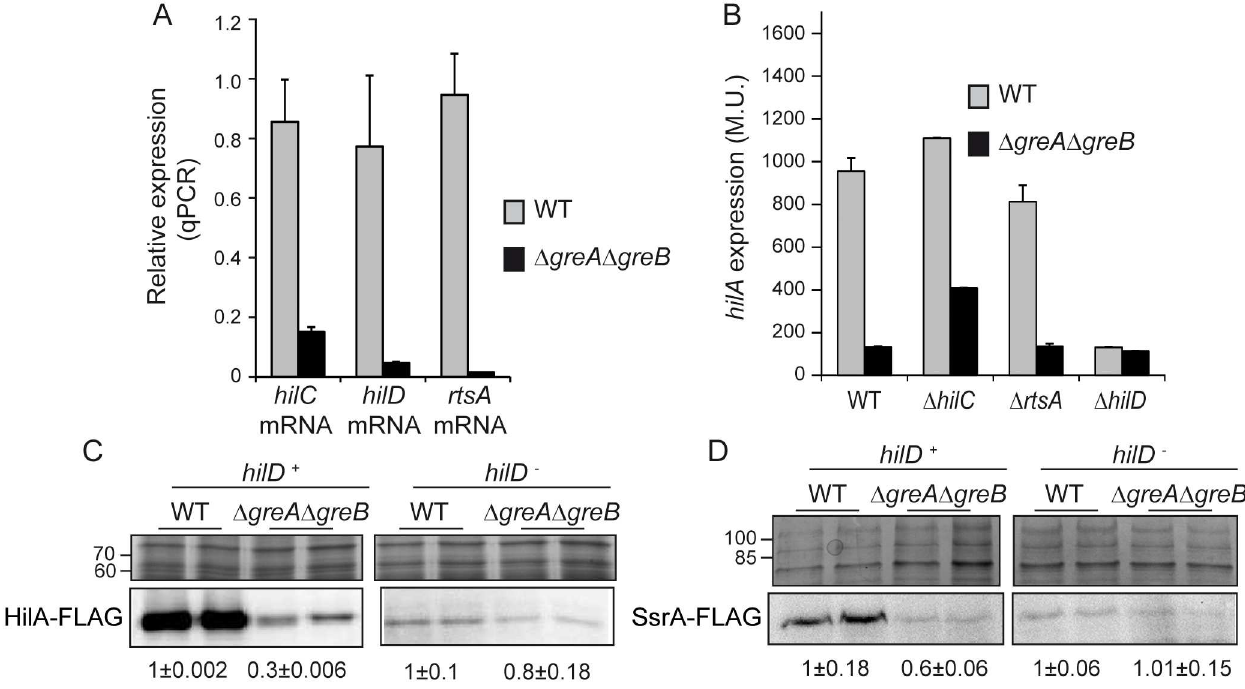
Fig 4. Gre factors-mediated regulation of S . Typhimurium virulence is focused in the regulation of the master regulator HilD. (A) Relative hilC , hilD and rtsA mRNA quantification by qPCR in WT and Δ greA Δ greB derivative strains. Results are normalizedafter detectionof gapA (GAPDH) that was used as an endogenouscontrol. Same RNA samples as in Fig 3B. (B) Transcriptional expressionof hilA in WT, hilC , rtsA and hilD derivative strains either proficient(grey bars) or deficient(black bars) in the Gre factors was monitored by β -galactosidaseactivity determination from a hilA :: lacZ fusion. In A and B, a bar shows the arithmetic mean of experimental results and the error bar indicatesthe standarddeviationfrom three biologicalreplicates. Immunodetection (lower panels) of HilA-FLAG protein (C) and the SPI-2 encodedSsrA-FLAG protein (D) in wholecell extracts from cultures of WT and Δ greA Δ greB derivativestrains in a hilD + and hilD - genetic backgrounds. The upper panelsare sectionsof Coomassie stained gels as loadingcontrols. In all cases bacterial cultures were grown in LB at 37˚C up to an OD 600nm of 2.0.